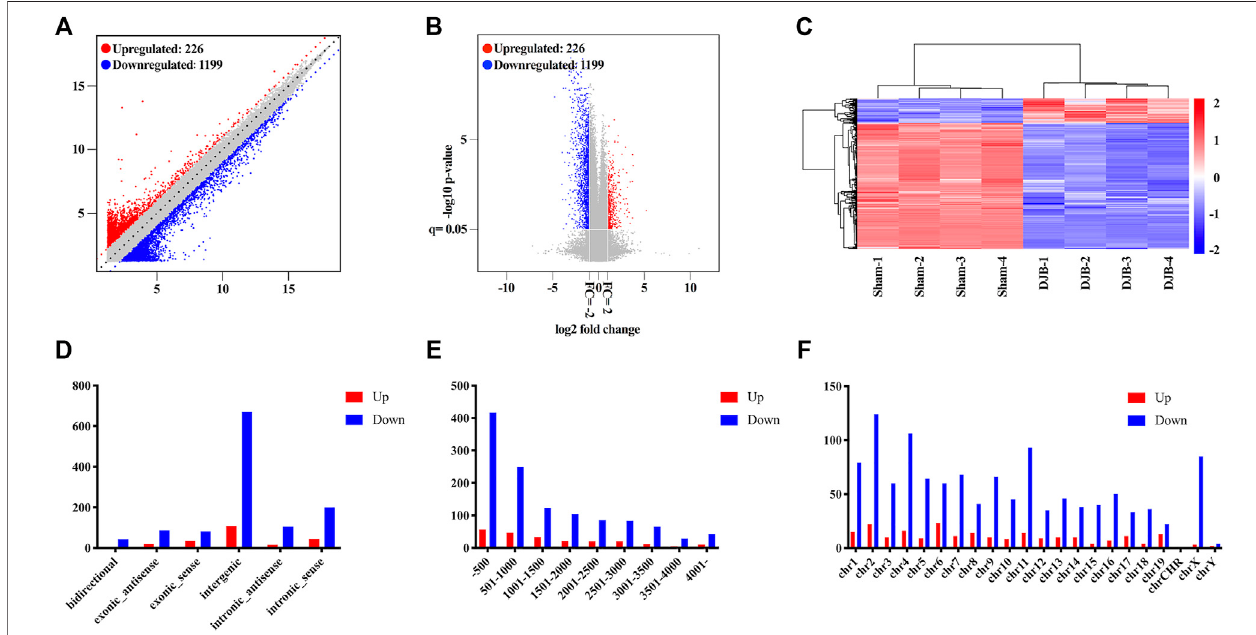
FIGURE3| Identi fi cationandanalysisofdistinctivelyexpressedlncRNAs.Scatterplot (A) andvolcanoplot (B) ofdifferentiallyexpressedlncRNAsbetweentheDJB and sham groups. (C) Heat map of lncRNAs showed hierarchical clustering of differentially expressed lncRNAs in DJB and sham mice (fold change ≥ 2, p < 0.05). Analysis of up- and downregulated lncRNAs based on classi fi cation (D) , length distribution (E) , and chromosome locus (F) .